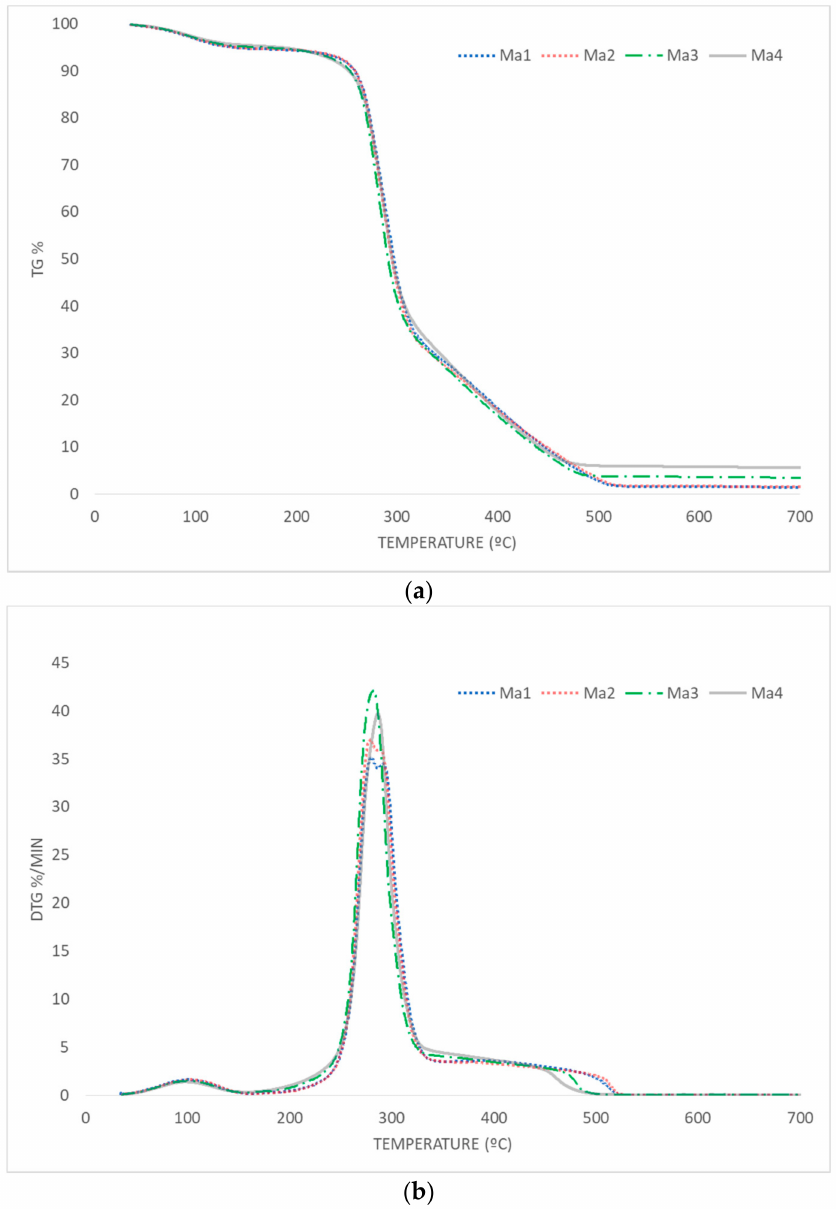
Figure 5. ( a ) TG combustion and ( b ) DTG